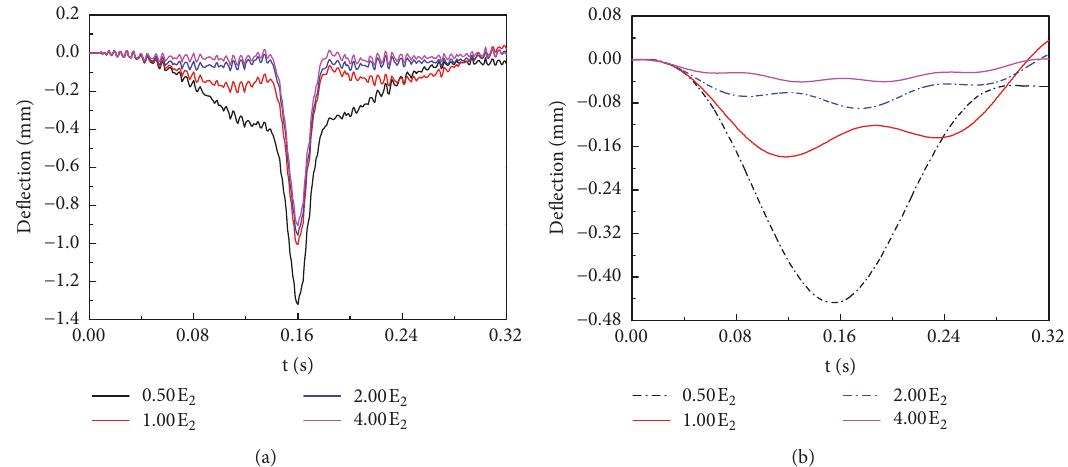
Figure 16: Comparison diagram of mid-span deflection time-history for double simply supported rail-bridge system under different stiffness of second beam: (a) first beam; (b) second